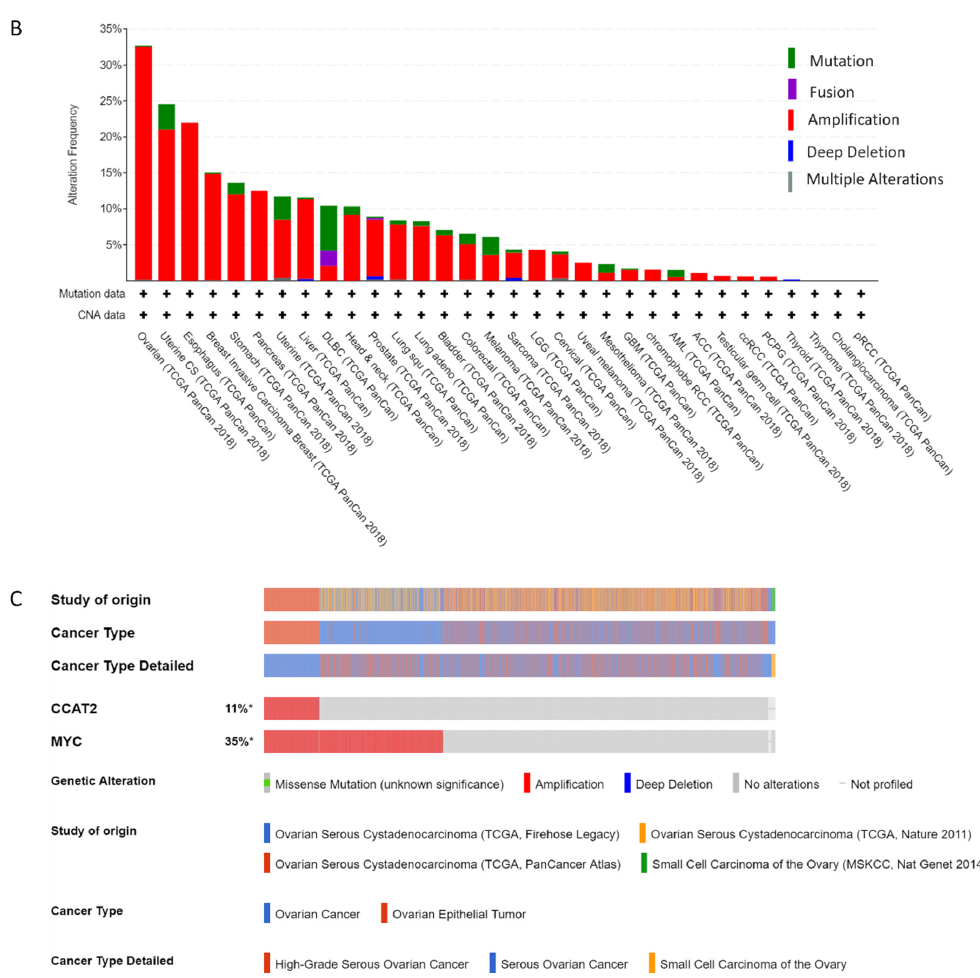
Figure 1. CCAT2 and MYC are most frequently altered in ovarian cancer samples against cross-cancer studies. ( A ) CCAT2 amplification frequencies are the highest in ovarian cancer samples. ( B ) The frequencies of MYC gene amplification are the highest in ovarian cancer samples. ( C ) The genomic alterations in a query of two genes CCAT2 and MYC across a set of ovarian cancer samples. Each row represents a gene. Each column represents an ovarian cancer sample. Red bars stand for gene amplifications, blue bars indicate deep deletions, and green squares are missense mutations.